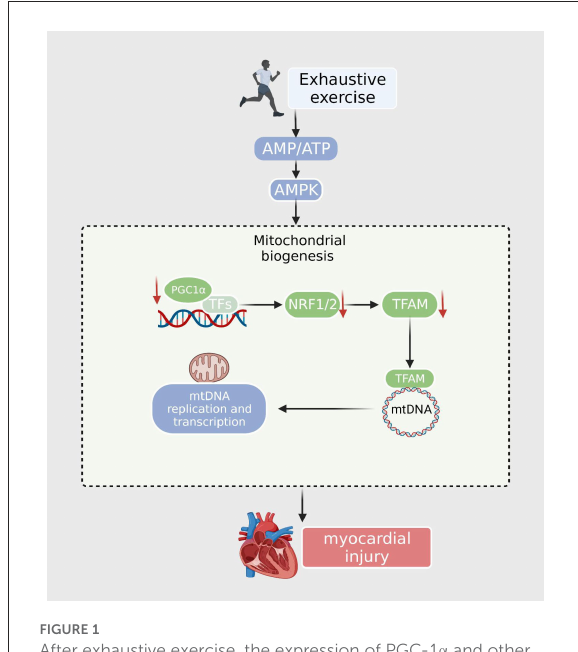
FIGURE1 After exhaustive exercise, the expression of PGC-1 α and other transcription factors (NRF1, NRF2) is downregulated. The TFAM is then reduced when imported into the mitochondria. TFAM downregulates the expression of nuclear encoding genes, resulting in decreased mtDNA synthesis, ATP synthesis, and mitochondrial